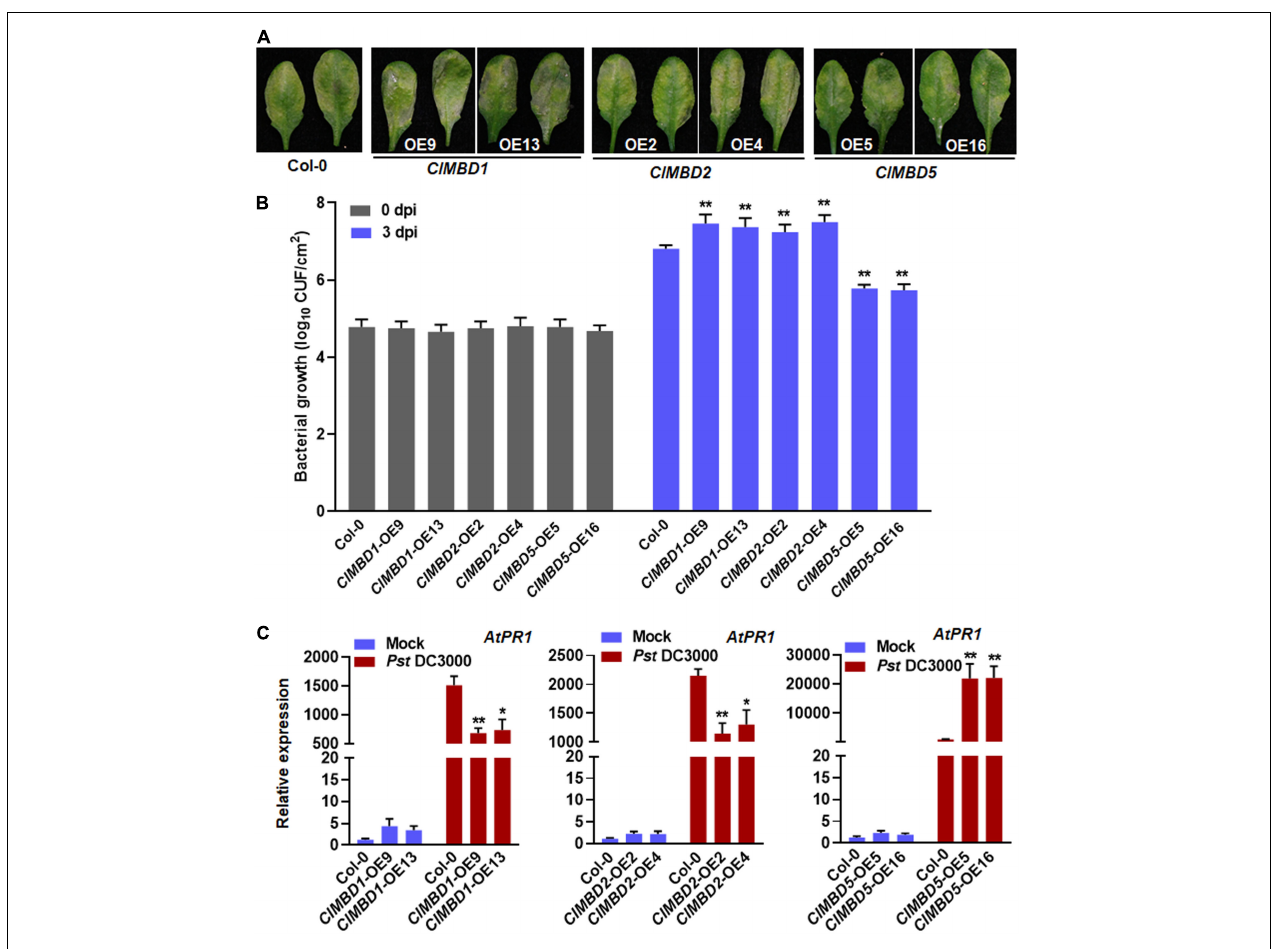
FIGURE 7 | ClMBD1 and ClMBD2 negatively but ClMBD5 positively regulate resistance of the transgenic Arabidopsis plants against Pseudomonas syringae pv. tomato DC3000. (A) Typical P. syringae pv. tomato DC3000-caused disease on WT, ClMBD1 -OE, ClMBD2 -OE, and ClMBD5 -OE plants. Four-week-old plants were inoculated by injecting with P. syringae pv. tomato DC3000 bacterial suspension (OD 600 = 0.0002) and photographed at 72 hpi. (B) In planta bacterial growth in inoculated leaves. Leaf samples were collected at 0 and 3 dpi and bacterial growth in CFU/cm 2 leaf area are shown. (C) Relative expression of AtPR1 in the mock- and P. syringae pv. tomato DC3000-inoculated plants. qRT-RCR was performed using AtActin as an internal control to analyze the expression level of AtPR1 Experiments in (A,B) were repeated for three times with similar results, and results from one representative experiment are shown. Data presented in (C) are the means ± SE from three independent experiments and * or ** above the columns indicate significant differences at p < 0.05 or p < 0.01 levels (Student’s t -test), respectively, between the ClMBD1 / 2 / 5 -OE plants and WT plants at the same time